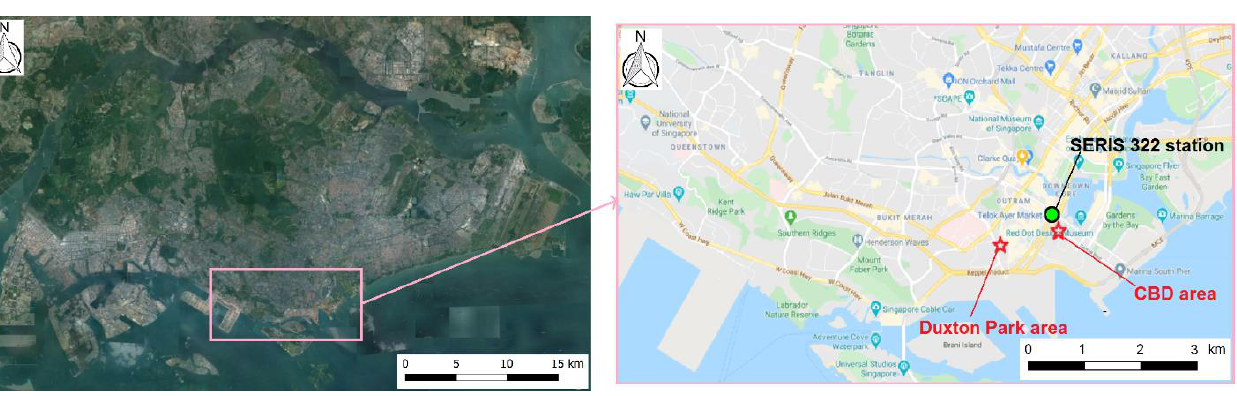
Figure 2. Location of the areas of study in Singapore (Duxton Park area and CDB area) as well as station 322 of the Solar Energy Research Institute of Singapore (SERIS) where solar irradiance values were obtained.